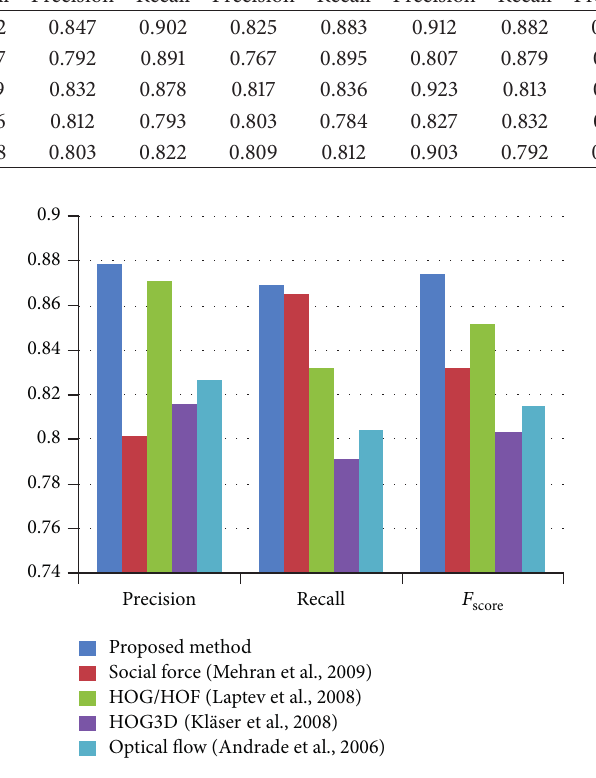
for all crowd score